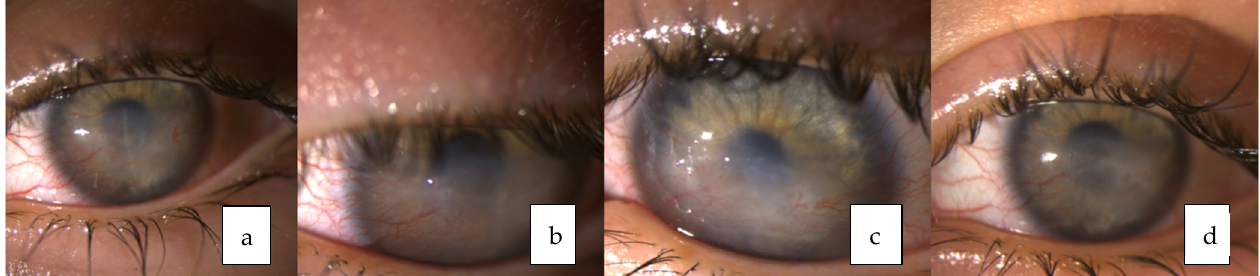
Figure 3. MRI of the patient. The arrow shows hypoplastic trigeminal nerve on the right side (MRI defect due to the cochlear implant).